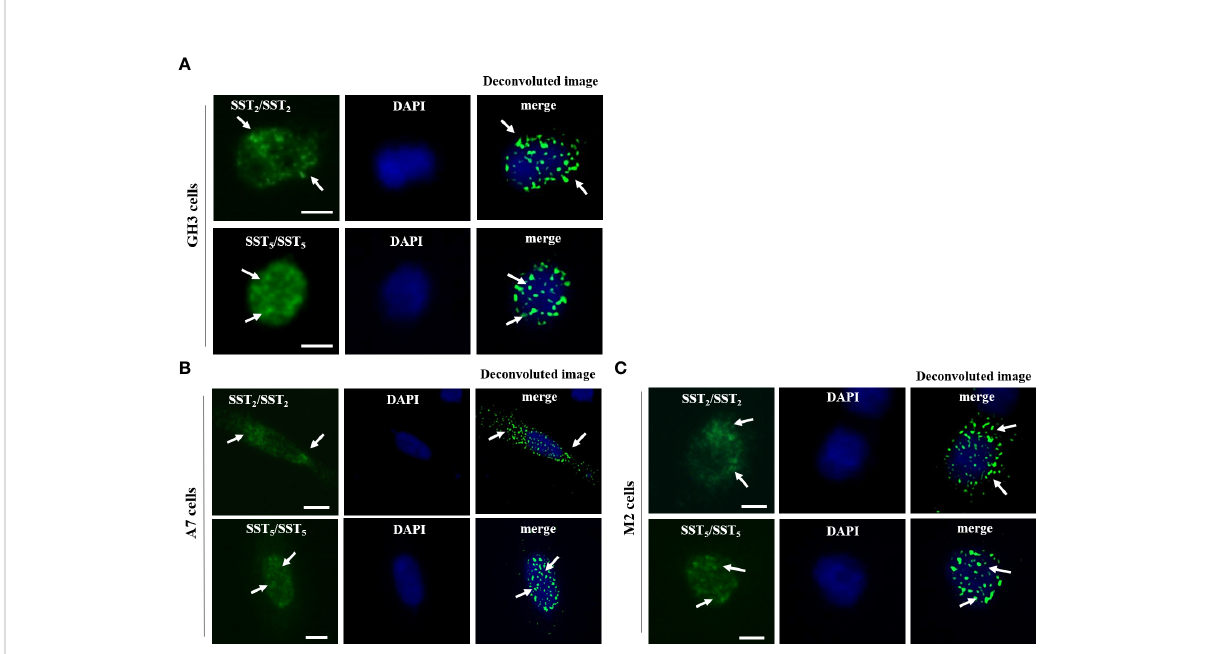
FIGURE 1 In situ detection of SST2/SST2 and SST5/SST5 homo-dimers. Representative in situ PLA experiment performed in GH3 (A) , A7 cells (B) , and M2 cells (C) showing SST 2 /SST 2 (upper panels) and SST 5 /SST 5 (lower panels) homo-dimers. For SST 2 /SST 2 homo-dimers, mouse anti-HA and rabbit anti- SNAP antibodies were used. For SST 5 /SST 5 homo-dimers, mouse and rabbit anti-SST 5 antibodies were used. PLA puncta representing homo-dimers are shown as green dots and nuclei are stained with DAPI in blue. A deconvoluted image of PLA events merged with DAPI is shown. White arrows indicated the localization of PLA puncta. Scale bars: 10 m